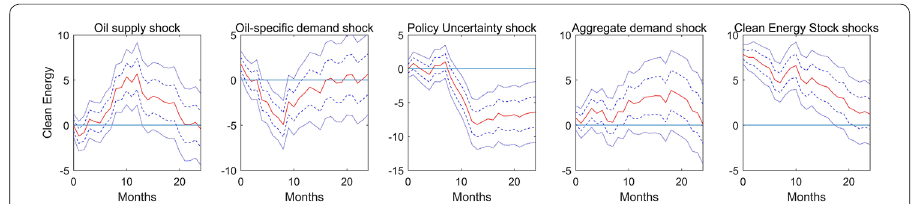
Fig. 2 Responses of clean energy industry returns to one and two standard deviation structural shocks: 2001:01–2018:12. Notes: The figure shows the impulse response functions to one and two standard deviation structural shock, the order of SVAR model is oil supply shocks, aggregated demand shocks, oil specific demand shocks, economic policy uncertainty index and the real stock returns of the clean industry described in the text. Point estimates are reported with one- and two-standard error bands constructed using a recursive-design wild